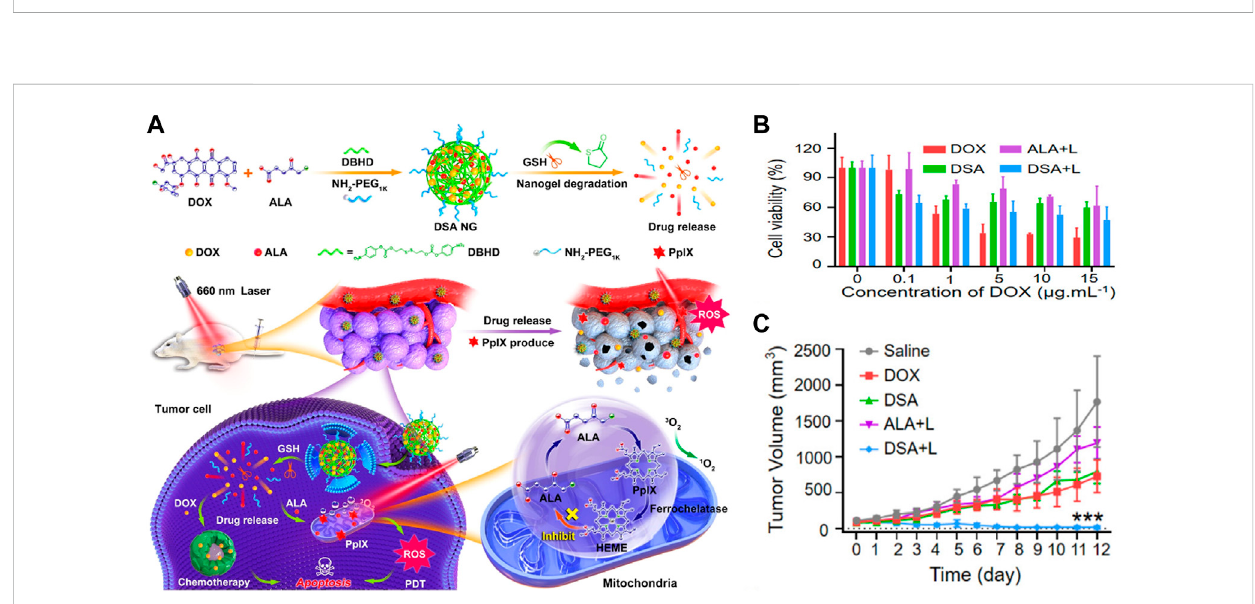
FIGURE 6 (A) Designandmechanism ofGSH-responsiveDSANG; (B) Cellviability against4T1cellsunderdifferenttreatments; (C)